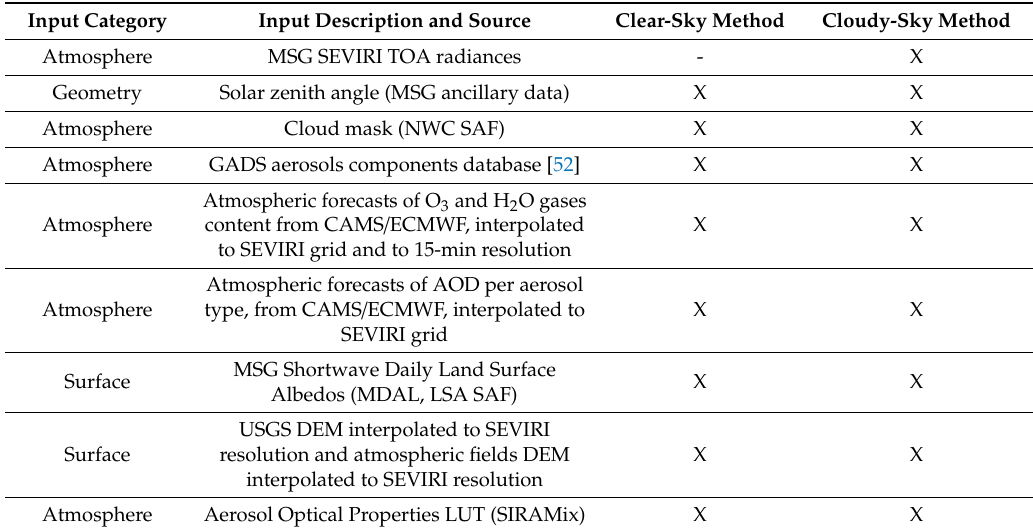
Table 2. Summary of the exploitation of each of the input dataset by the processing modules.